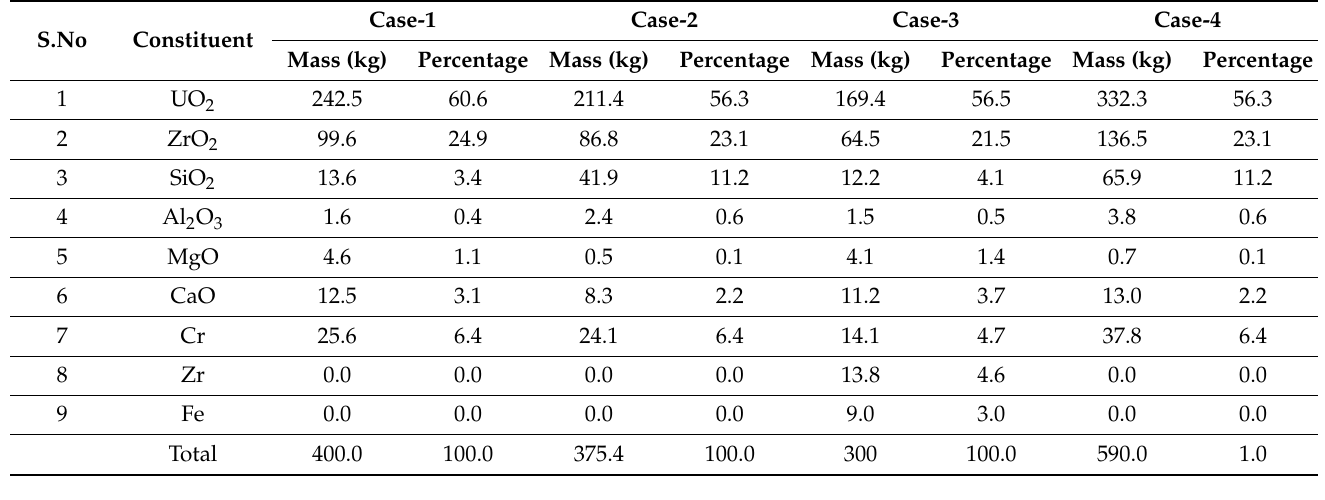
Table 6. Composition of different corium used for thermochemical analysis.